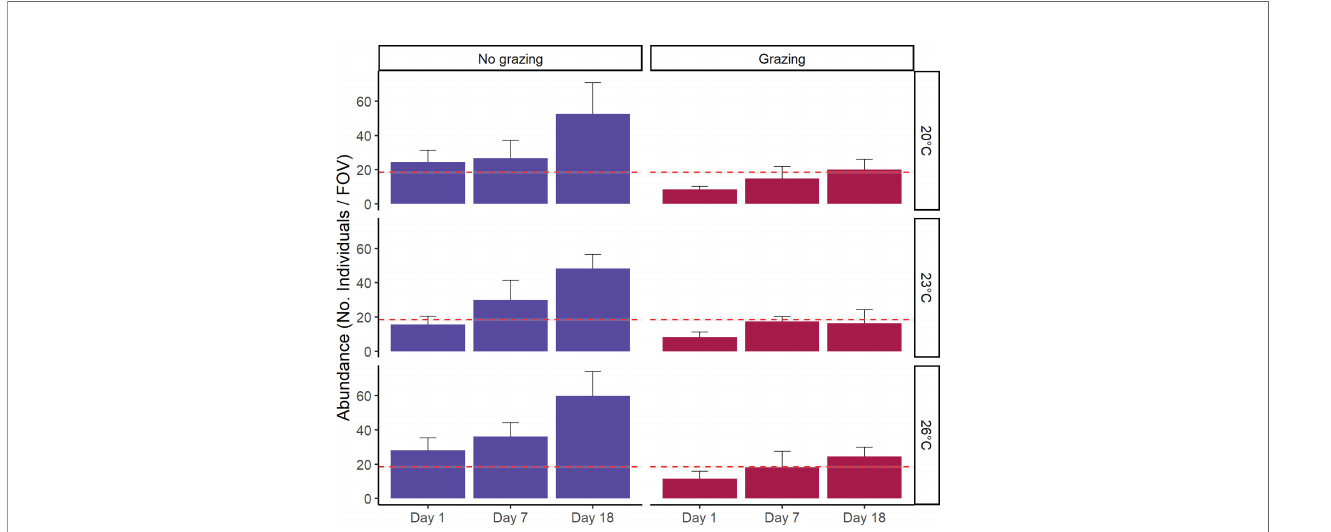
FIGURE 4 | Mean abundance [No. of individuals per fi eld of view (FOV) (3.2mm 2 )] after grazing tracked over an 18-day period after grazing. Separate bar plots are shown for grazer treatment. Error bars represent SE, n = 5. The red dashed line represents the mean abundance prior to grazer exposure (baseline data), with the grey area denoting the 95% con fi dence